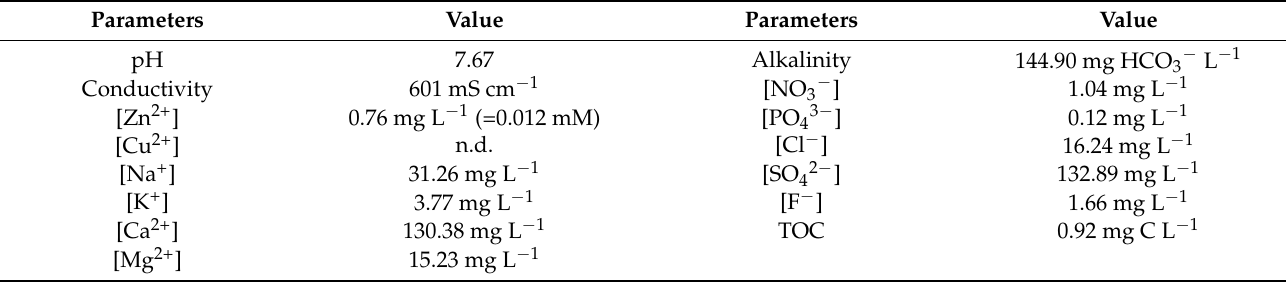
Table 2. Water physico-chemical parameters at the sampling point of the Osor River. Parameters Value Parameters Value pH